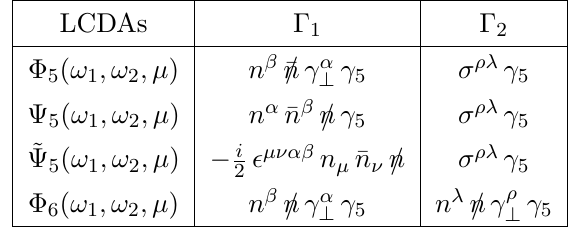
Table 1 . The Dirac structures of the interpolating currents entering the correlation function (4.1) and the corresponding three-particle B -meson